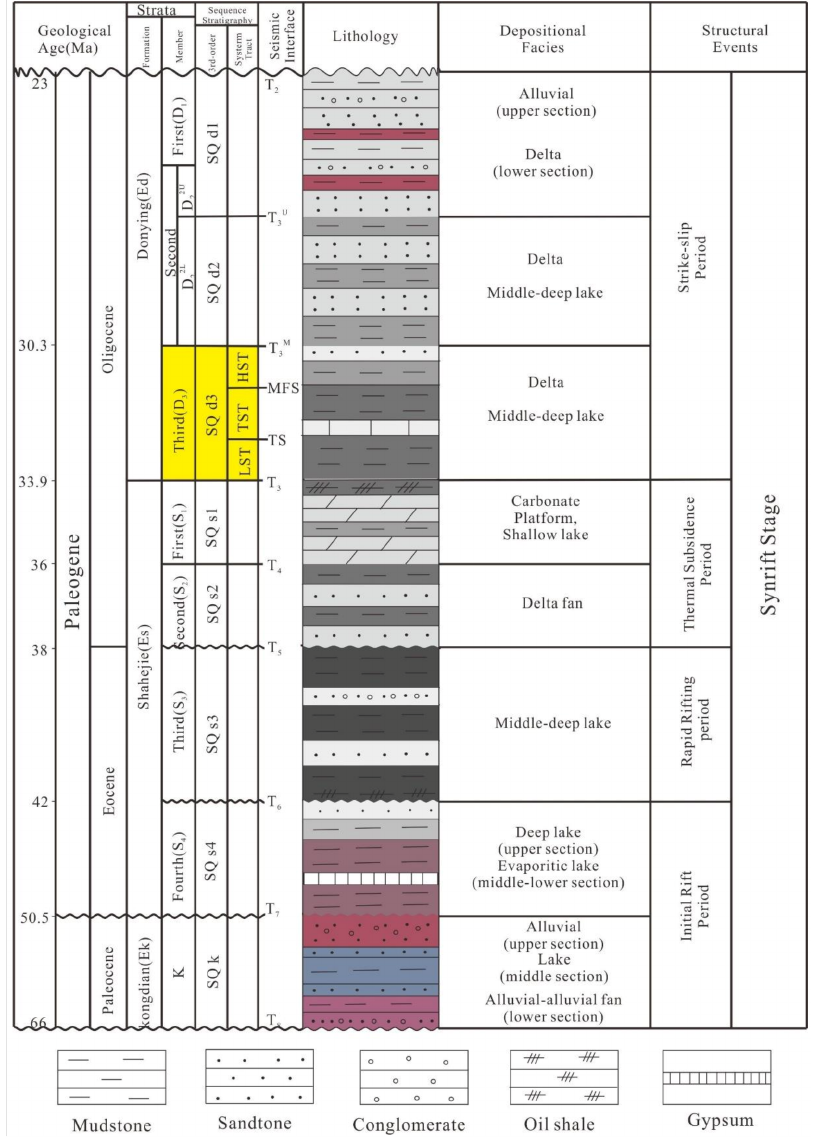
Figure 3. Comprehensive stratigraphic column of Shahejie Formation and Dongying Formation in Liaodong Bay Depression, Bohai Bay Basin (modified after Huang et al., 2016